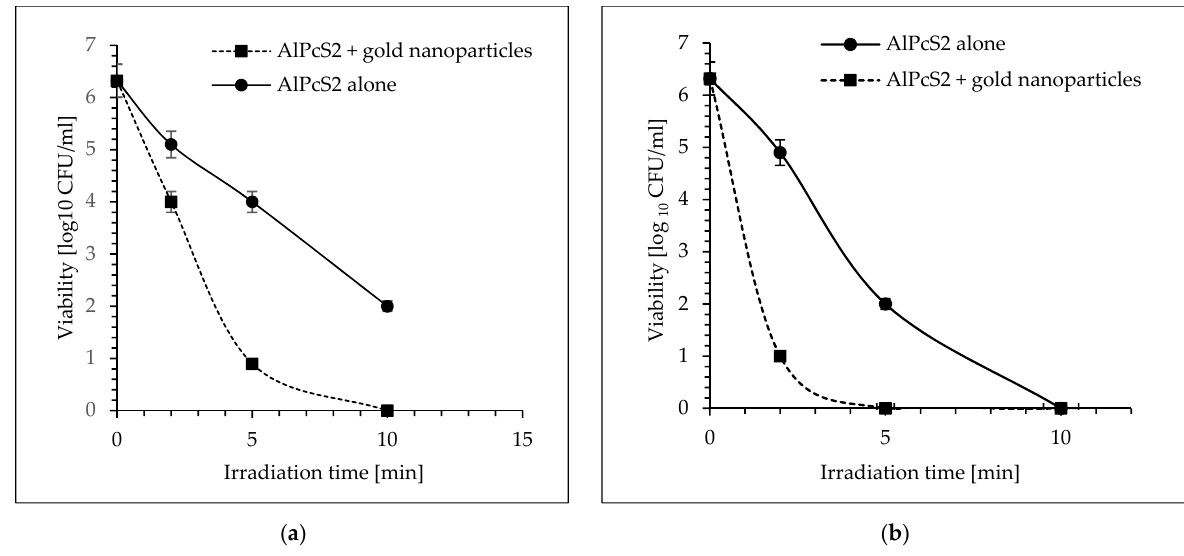
Figure 6. The effect of gold nanoparticles on the effectiveness of photokilling of S. aureus with AlPcS 2 as a photosensitizer. ( a ) laser light ( λ = 650 nm; the radiation power density of 105 mW cm − 2 ); ( b ) laser light ( λ = 650 nm; the radiation power density of 210 mW cm − 2 ). Average SD of three independent experiments is shown. The efficiency of this treatment was considered as statistically significant for all groups ( p < 0.05).